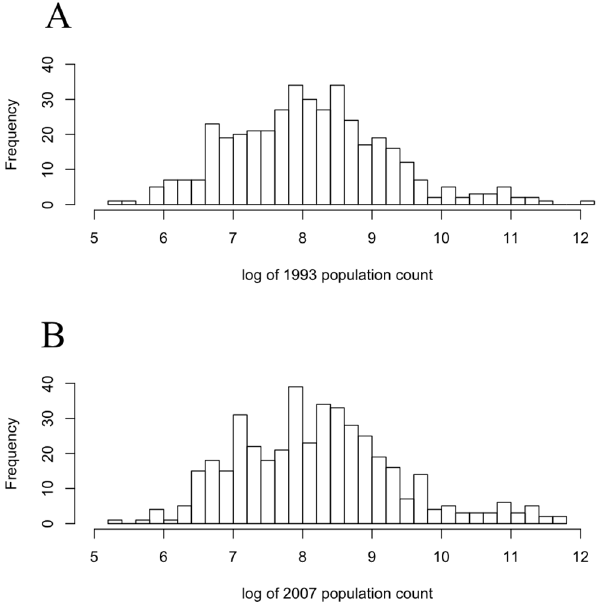
Figure 1. Population count by district for all regions included in the analysis for A) 1993 and B)